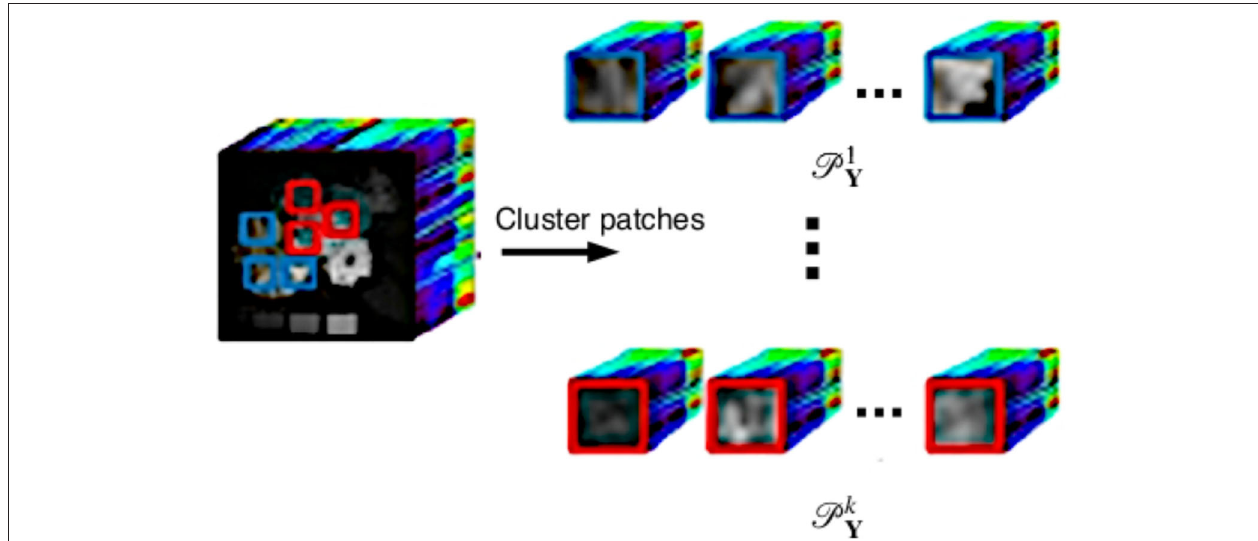
FIGURE 2 | Clustering the set of patches P Y into k = 2